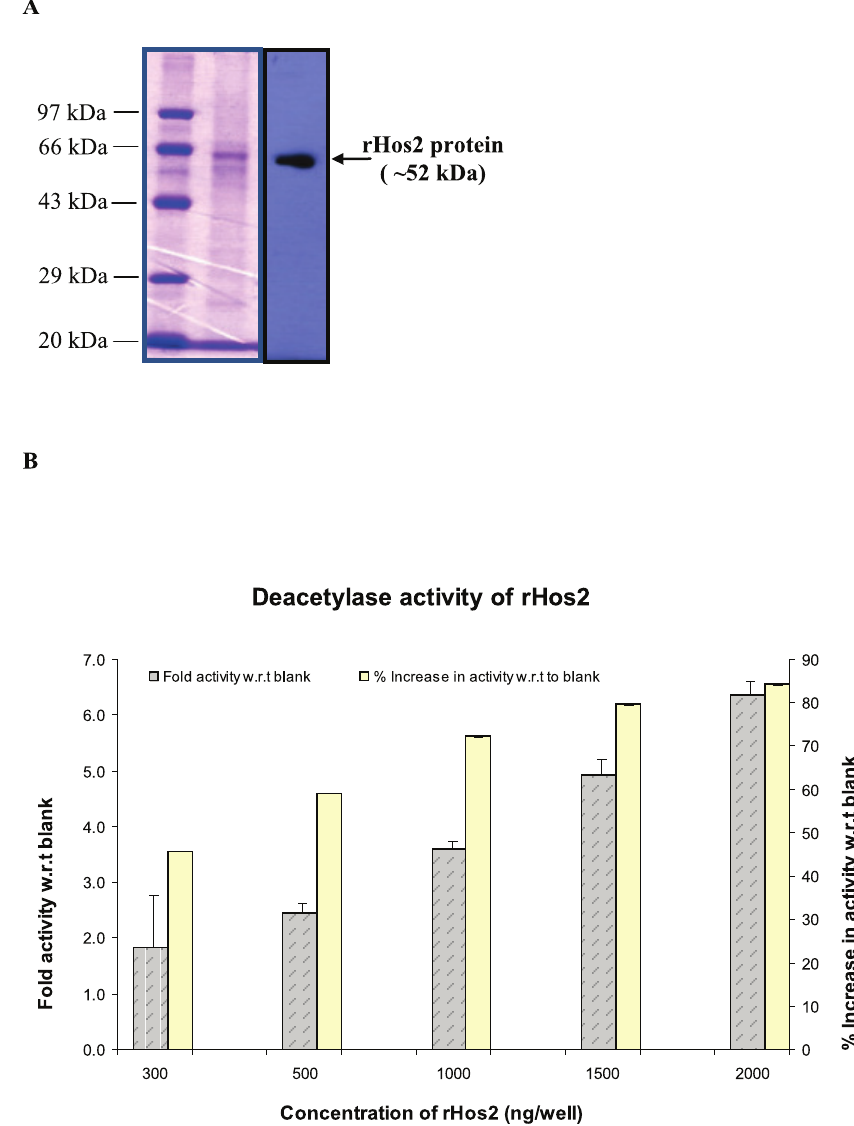
Figure 1. Expression of his-tagged Hos2 in insect cells and its characterization. ( A ) Sf9 cells were infected with 10 MOI of recombinant Hos2 baculovirus for 72 hours and the soluble fraction was collected. Two μg of protein was separated on a 10% SDS-PAGE. Lane 2 is coomassie stained SDS-PAGE and Lane 3 is Hos2 protein recognized by polyclonal anti sera from mice. Molecular weight markers are labeled at the left side (Lane 1) of the blot. ( B ) Concentration dependent increase in deacetylase activity following incubation of baculo expressed Hos2 with Boc-lys (ac)-AMC fluorogenic peptide substrate in 1 hr assay at 37°C. Assays were carried out in triplicates and analysed for statistical significance by one way ANOVA (Bonferroni’s Multiple Comparison Test) using GraphPad Prism software. active in deacetylating the lysine residue and the activity increased significantly ( P < 0.05 ) with an increase in Hos2 concentration (Figure